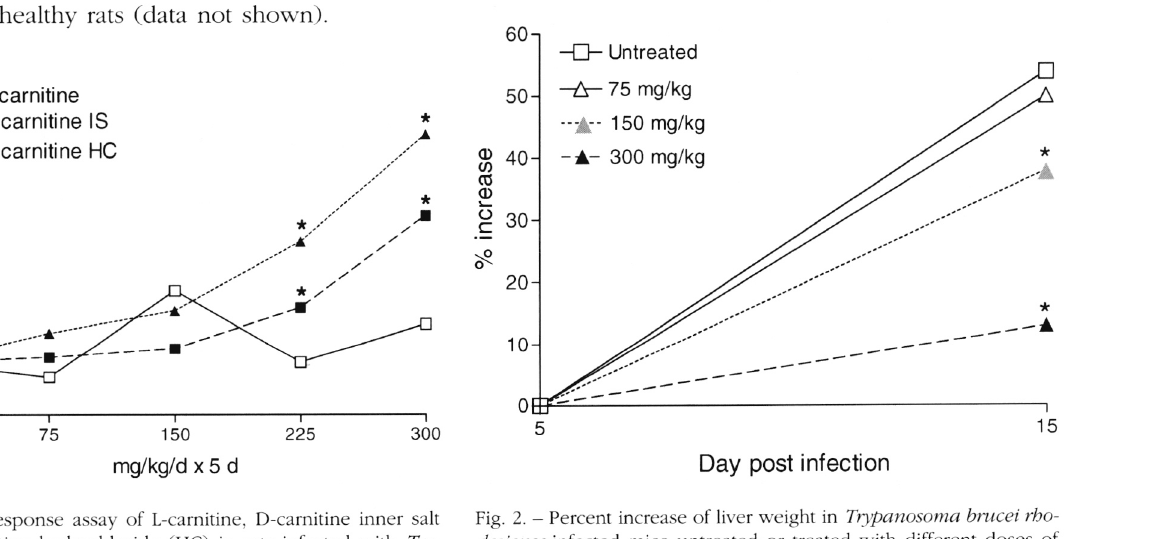
Fig. 1. - Dose-response assay of L-carnitine, D-carnitine inner salt (IS) and D-carnitine hydrochloride (HC) in rats infected with Try­ pan osom a lewisi. * Significantly different (P < 0.05) from L-carnitine at the same dosa­ ges.